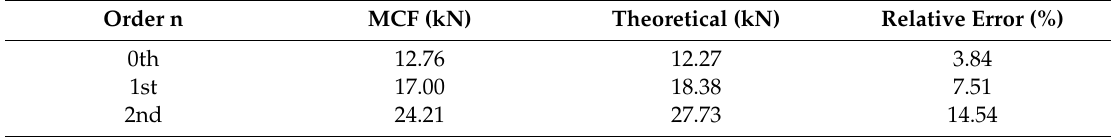
Table 5. Comparison of the FEA and theoretical predictions of the average crush force.